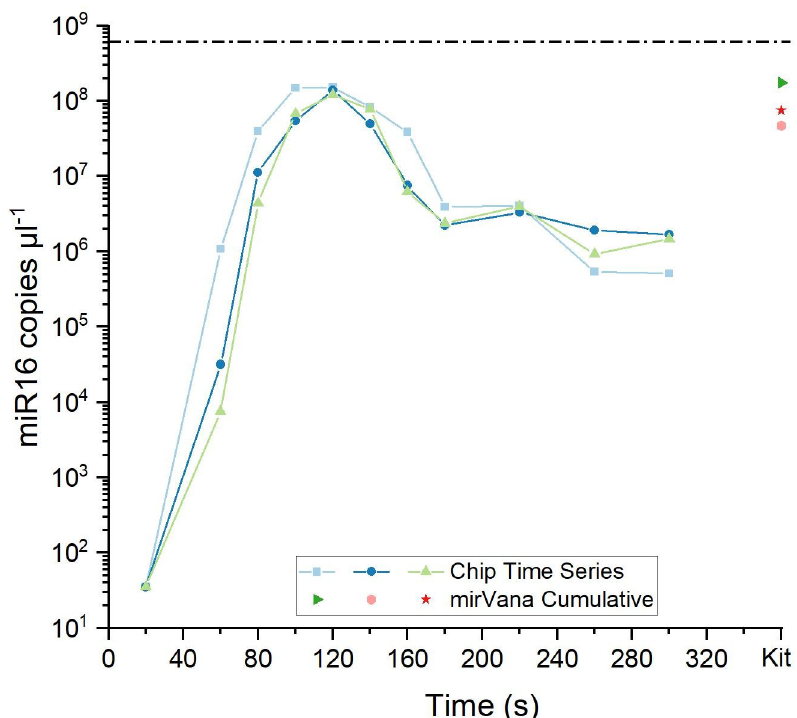
Fig 3. Comparison of GEE performance with mirVana miRNA extraction kit. Solid lines: GEE elution profile of miR16. Single points: miR16 extracted with the mirVana kit. Dashed line: Concentration of the input sample for GEE and kit